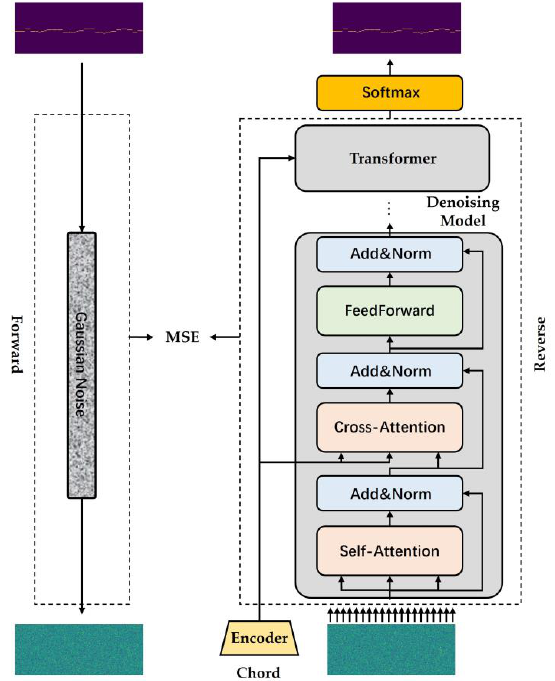
Figure 2. Model structure of MelodyDiffusion.